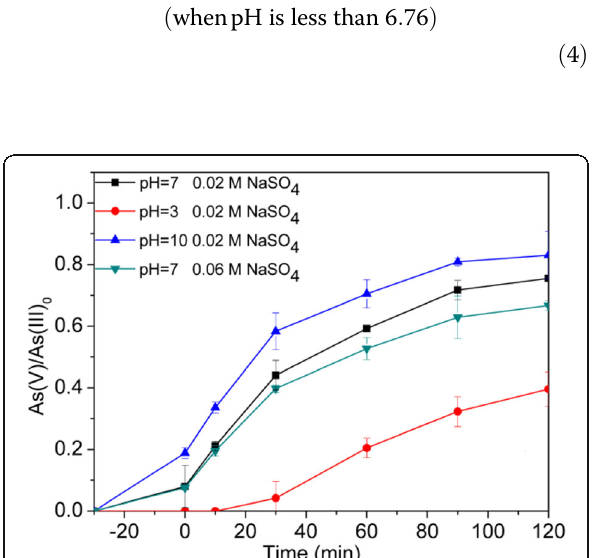
Fig. 6 Effects of pH and ionic strength on the photocatalytic oxidation of As(III). Ag@AgCl core – shell nanowires synthesized with the mole ratio of Ag nanowires:FeCl 3 =2.32:2.20, and the experimental conditions were [Ag@AgCl] = 0.3 g/L, [As(III)] 0 = 2.0 mg/L, initial pH = 7.0, and air- equilibrated, P = 300